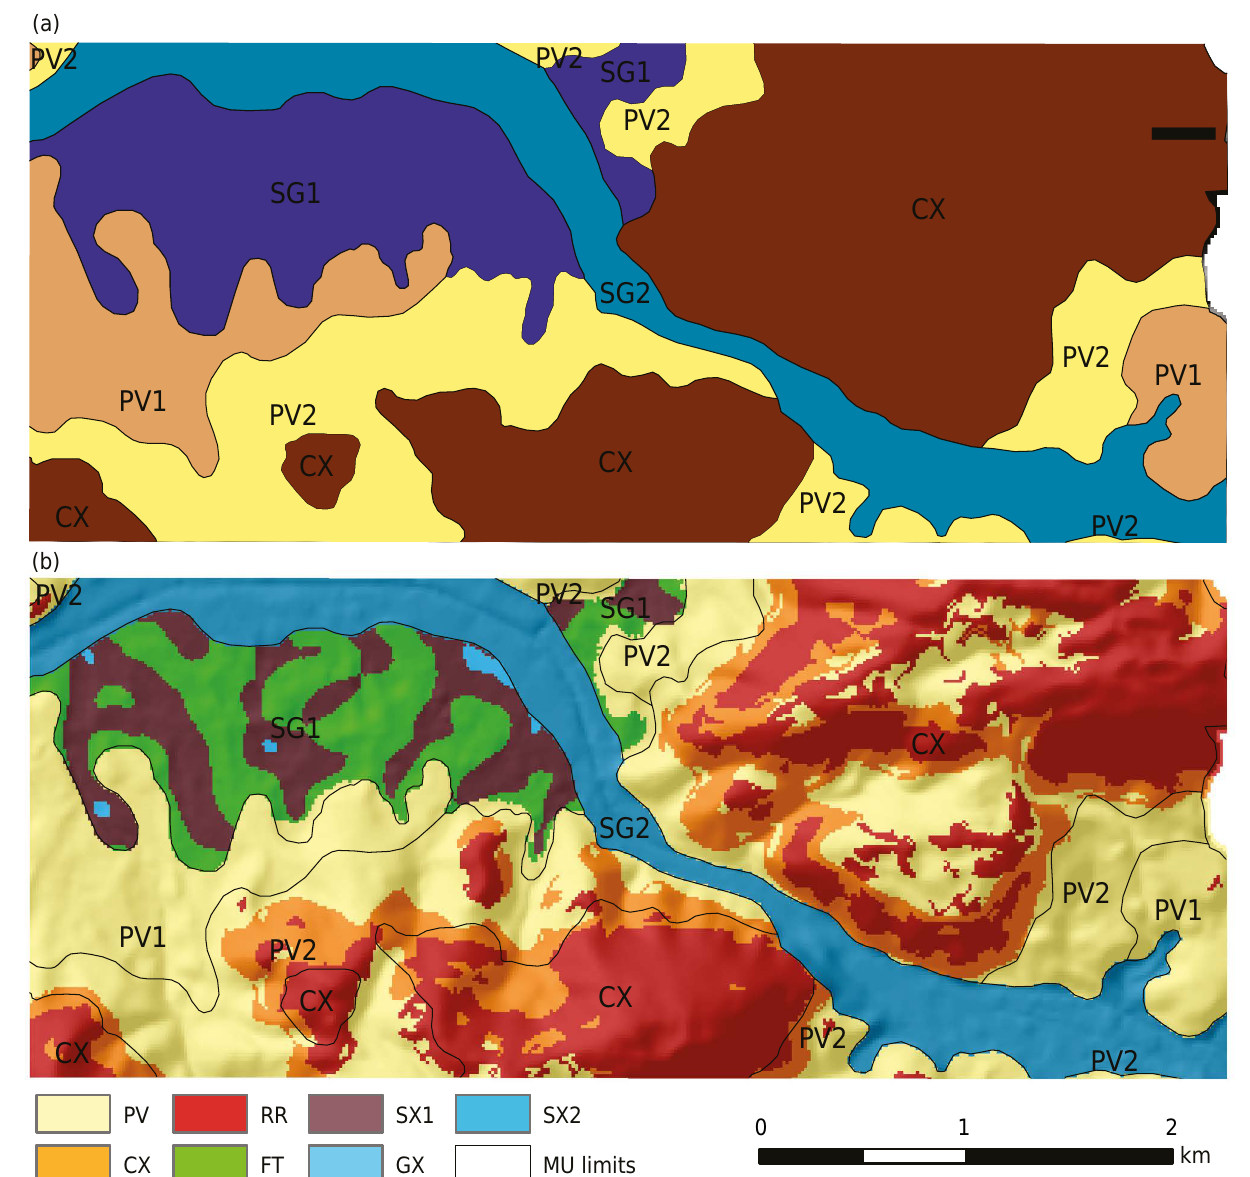
Figure 3. Comparison of a part of the original (a) and of the disaggregated (b) soil map. The acronyms in the images and in the legend correspond to the map units of the original and of the disaggregated soil map,